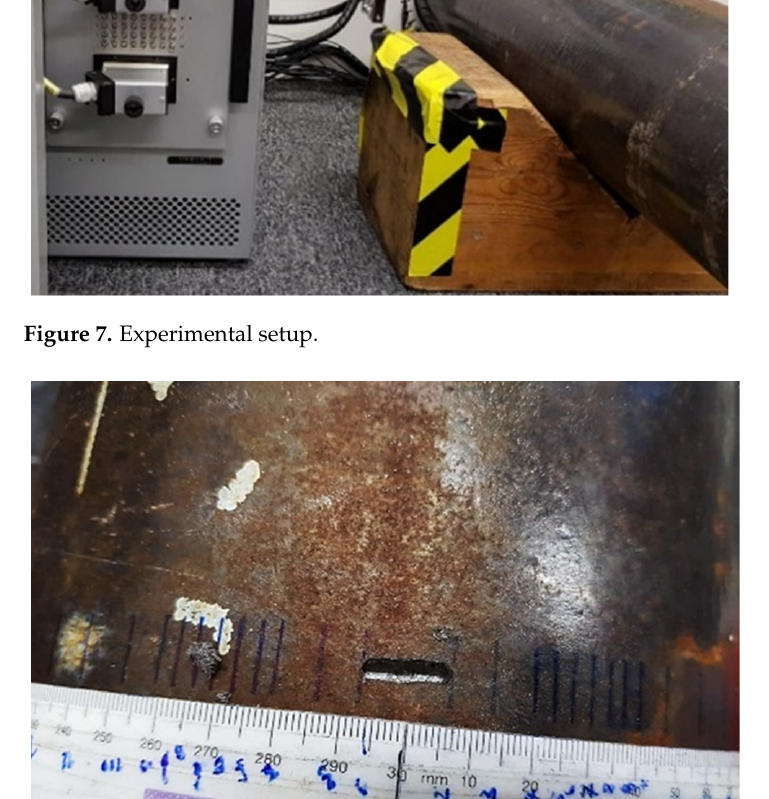
Figure 9. Comparison of FWHM sizing capabilities of CSM, TFM and PWI using FE simulations. From Figure 9, the maximum achievable resolution by SH0 CSM is around 1.4 λ SH0 which is consistent with results presented in [4], where the angular spectrum method im- plementation of CSM was used. These comparable results mean that the time domain im- plementation of synthetic focusing imaging algorithm yields the same resolution as the